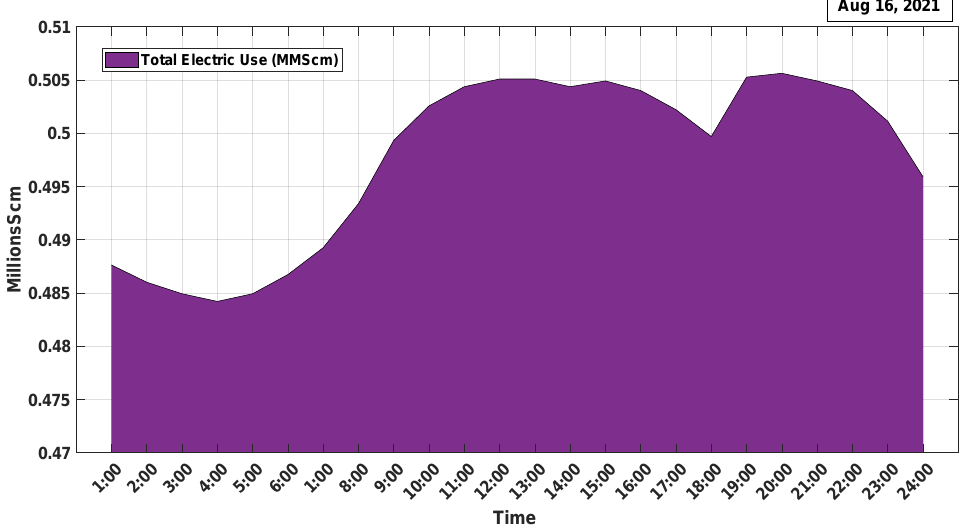
Figure 22. Demand for NG for electric use—stage